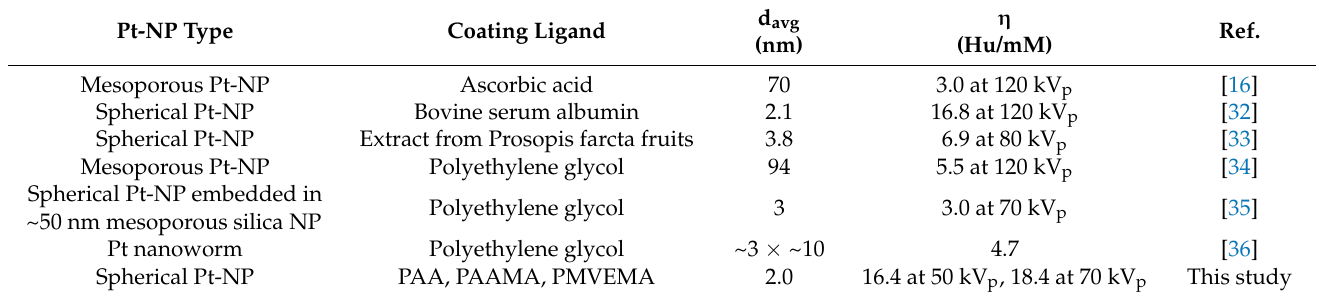
Table 5. Comparison of X-ray attenuation efficiency ( η ) with other